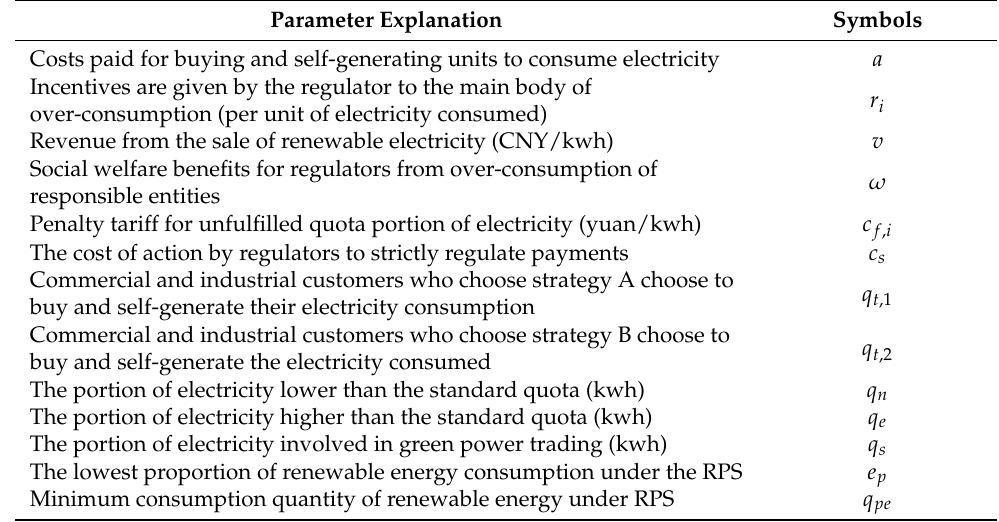
Table 1. Notation for variables and parameters.